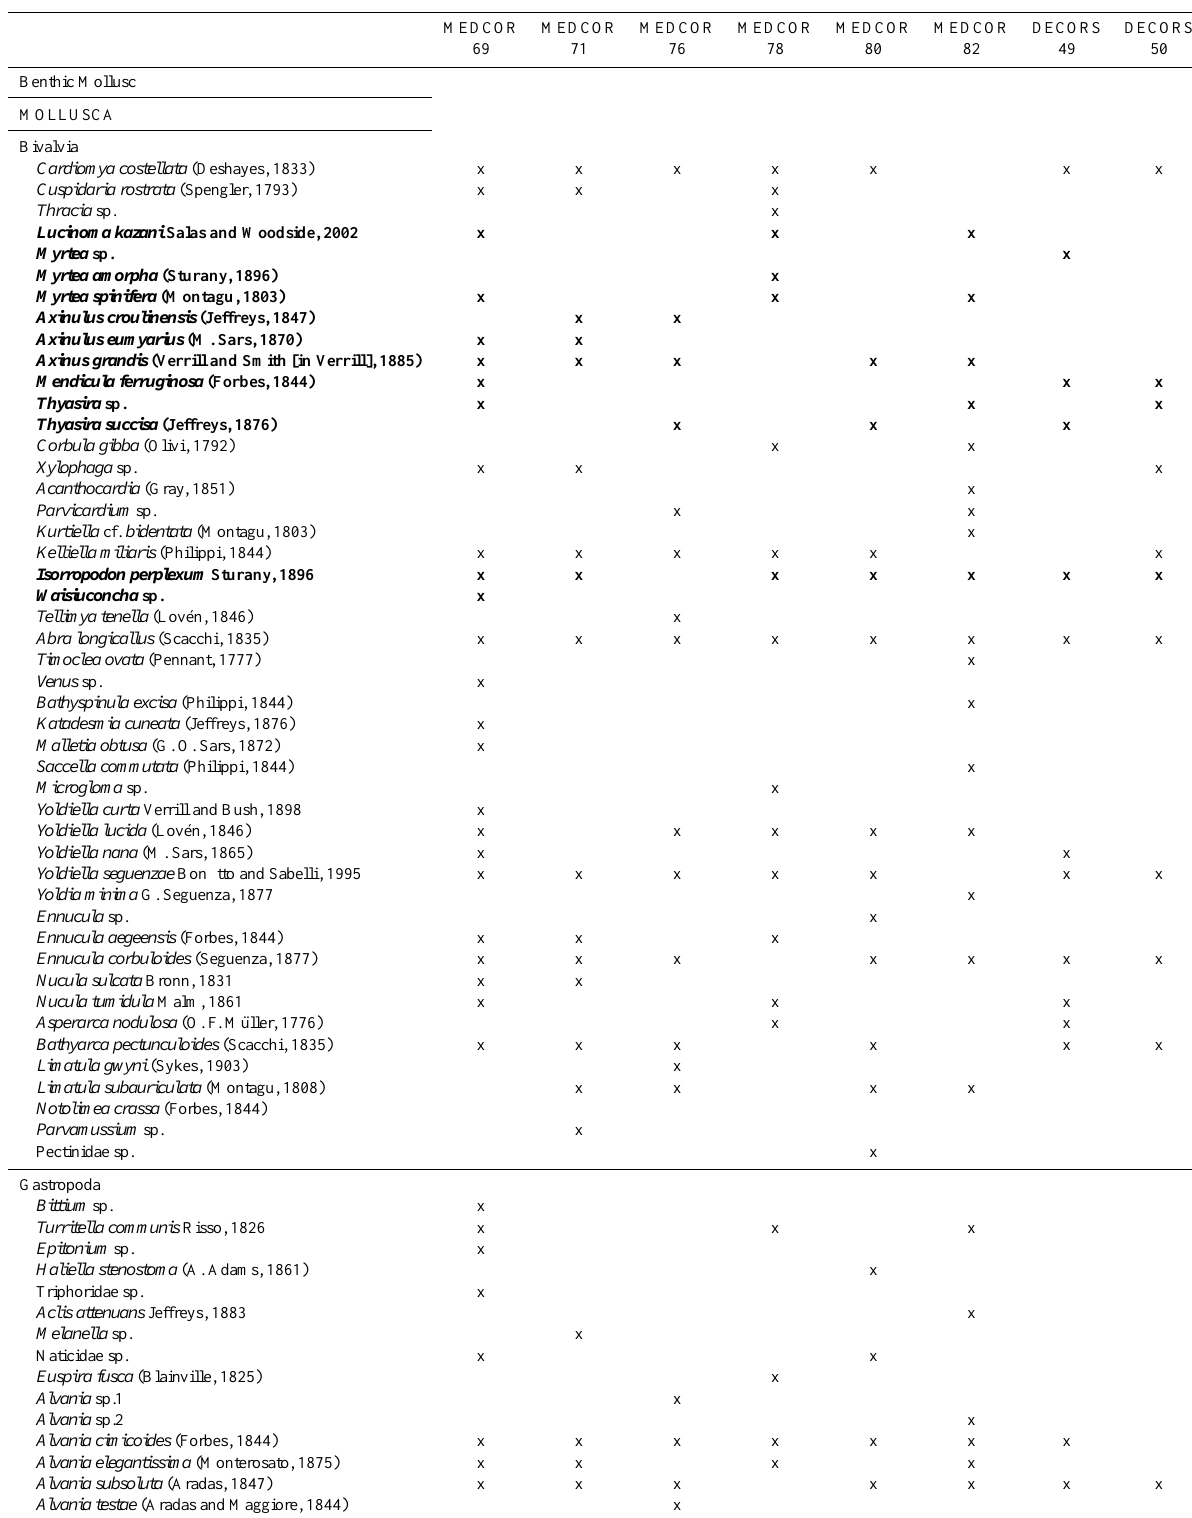
Table A1. Benthic and pelagic molluscs recovered from the GBPF during cruises MEDCOR and DECORS: taxa of proven or putative chemosymbiotic type are